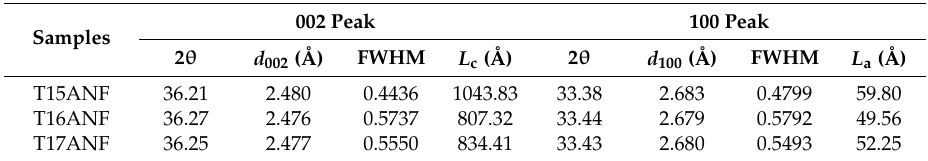
Table 3. The crystallite height ( L c ) and width ( L a ) of AlN and the interlayer spacing values obtained from